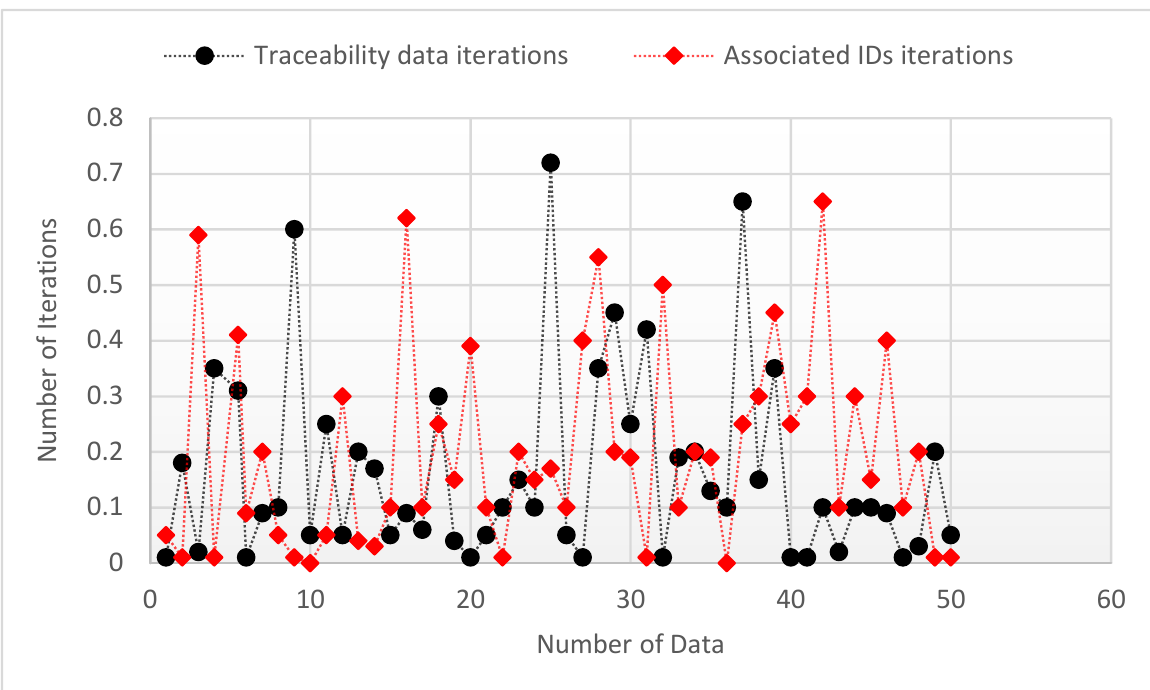
Figure 13. Key performance of number of the